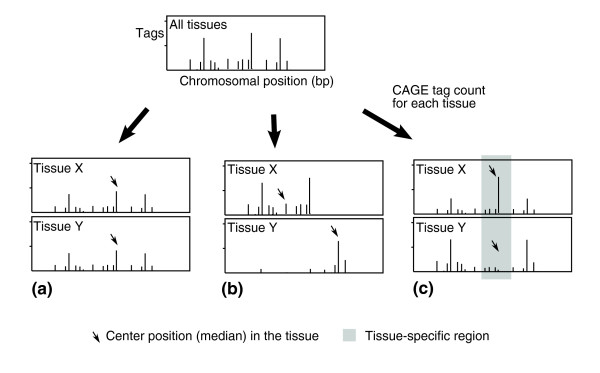
Possible cases of TSS usage among tissues. Possible cases of TSS usage sharing the same static structure of TSS: (a) TSS usage is identical between tissues X and Y; (b) upstream sites are favored in tissue X whereas downstream sites are favored in tissue Y; and (c) some subregions exhibit distinct TSS usage between tissues. The CAGE tag count of each tissue at each position is displayed as a vertical line, where the x-axis indicates genomic coordinates or chromosomal location and the y-axis indicates the CAGE tag count. bp, base pairs; CAGE, cap analysis of gene expression; TSS, transcription start site.